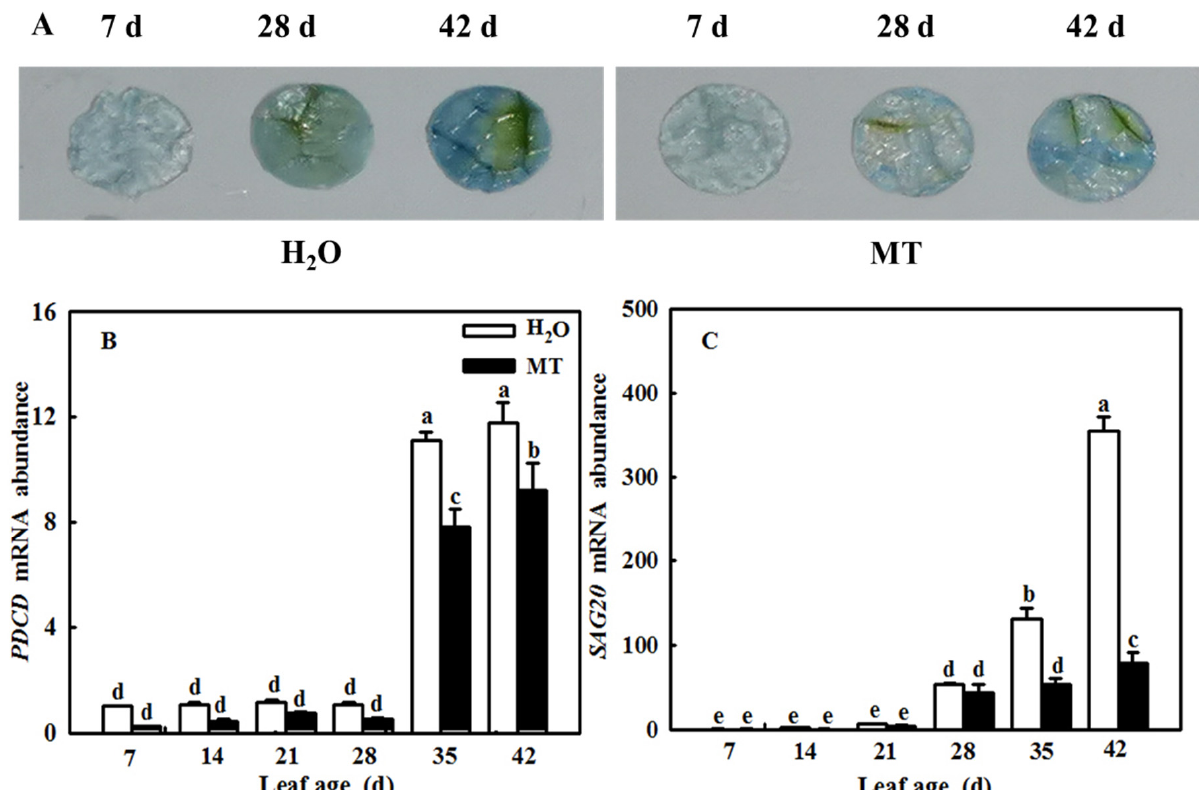
Figure 7. The effect of exogenous MT on cell-death- and senescence-related gene mRNA abundance in different age leaves of cucumber plants in a solar greenhouse. ( A ) The stain of programmed cell death; ( B ) PDCD mRNA abundance; ( C ) SAG20 mRNA abundance. At the three-leaf stage, the new leaf at the top was labeled 0 days and then labeled at 7, 14, 21, 28, 35, and 42 days. Meanwhile, cucumber plants were sprayed with 100 μ mol·L − 1 MT every 7 days, and plants treated with H 2 O were the control. The different leaf-age leaves were sampled for trypan blue staining and gene mRNA abundance determination. All values shown are mean ± SD ( n = 3). a, b, c, d, and e indicate that mean values are significantly different among samples ( p < 0.05).